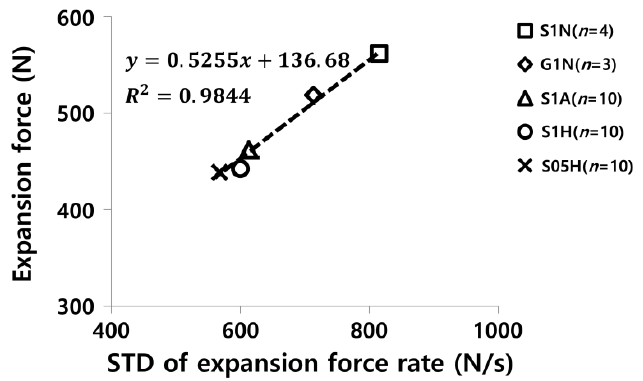
Figure 7. Correlation between the expansion force and standard deviation of the expansion force rate from Al tube expansion experiments.